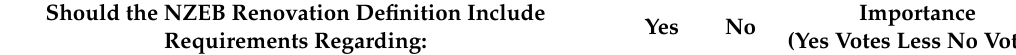
Table 2. Results of the survey on the potential indicators of NZEB renovation definition. DHW: domestic hot water; RES: renewable energy